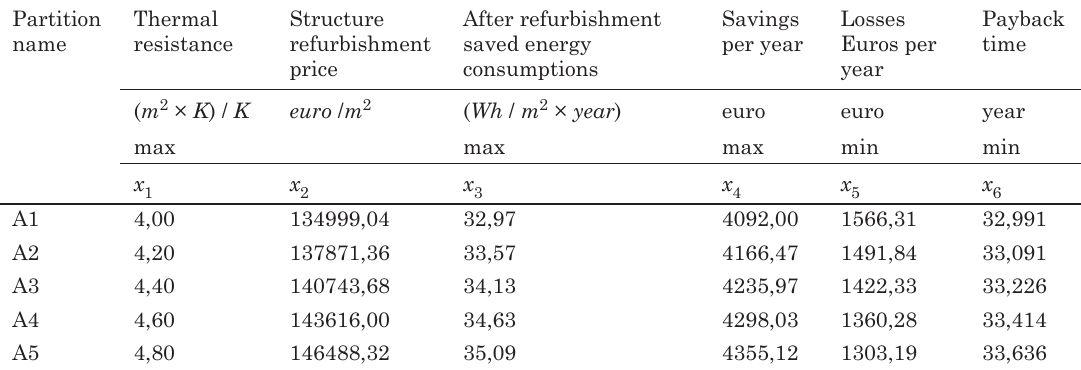
Table 6. Selected values from efficient interval